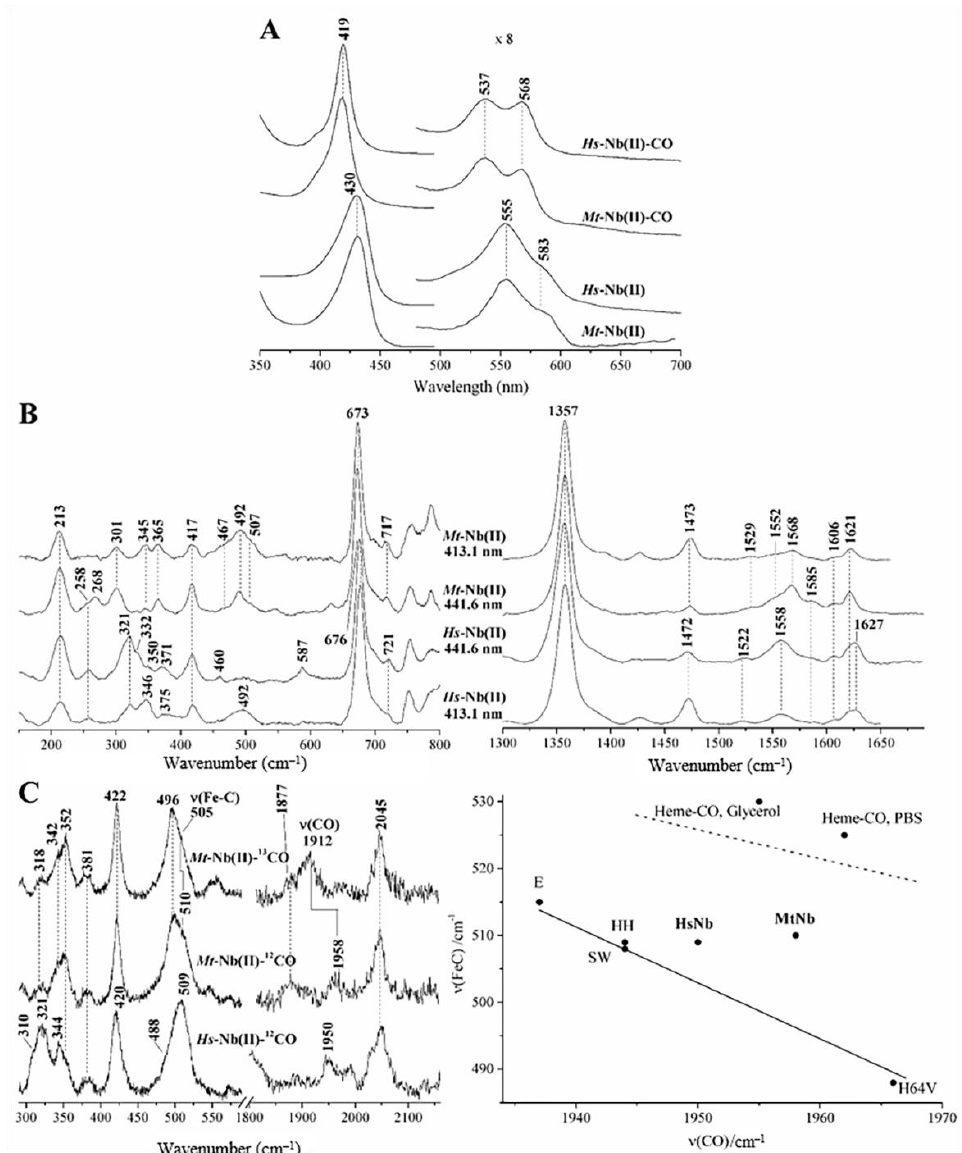
Figure 1. UV-Vis and RR spectra of Mt -Nb(II), Mt -Nb(II)-CO, Hs -Nb(II), and Hs -Nb(II)-CO. ( A ) UV-Vis spectra of Mt -Nb(II), Mt -Nb(II)-CO, Hs -Nb(II), and Hs -Nb(II)-CO at pH 6.0 and room temperature. ( B ) RR low frequency (left) and high frequency (right) spectra of Mt -Nb(II) (top) and Hs -Nb(II) (bottom) at pH 7.4 and room temperature with 413.1 and 441.6 nm excitation wavelength. Experimental conditions: 15 mW at the sample, 20 min integration time. ( C ) left : RR spectra of Mt -Nb(II)- 13 CO (top), Mt -Nb(II)- 12 CO (middle), and Hs -Nb(II)- 12 CO (bottom) in the 300–600 and 1800–2100 cm -1 regions (left and right, respectively), at pH 7.4 and room temperature with 413.1 excitation wavelength. Experimental conditions: 1 mW at the sample, 1 h (low-frequency region) or 2 h (high-frequency region) integration time. ( C ) right : Back-bonding correlation plot for the ν (Fe-C)/ ν (CO) stretching frequencies of the CO complexes of Mt -Nb and Hs -Nb together with heme-model compounds and representative Mbs, namely Pc -Mb, Cc -Mb, and the His64Val mutant of Pc -Mb (His64Val), at pH 7.4 and room temperature. The lower line represents six-coordinate carbonylated heme-proteins with imidazole as the sixth ligand; the upper line represents five-coordinate species, with no trans ligand, or six-coordinate carbonylated hemes with weak trans ligand. In the low-frequency region of the spectrum, obtained with the 441.6 nm excitation line, an intense band was observed at 213 cm − 1 that decreases upon excitation with the 413.1 nm in both Mt -Nb(II) and Hs -Nb(II) (Figure 1B). This band was assigned to the ν